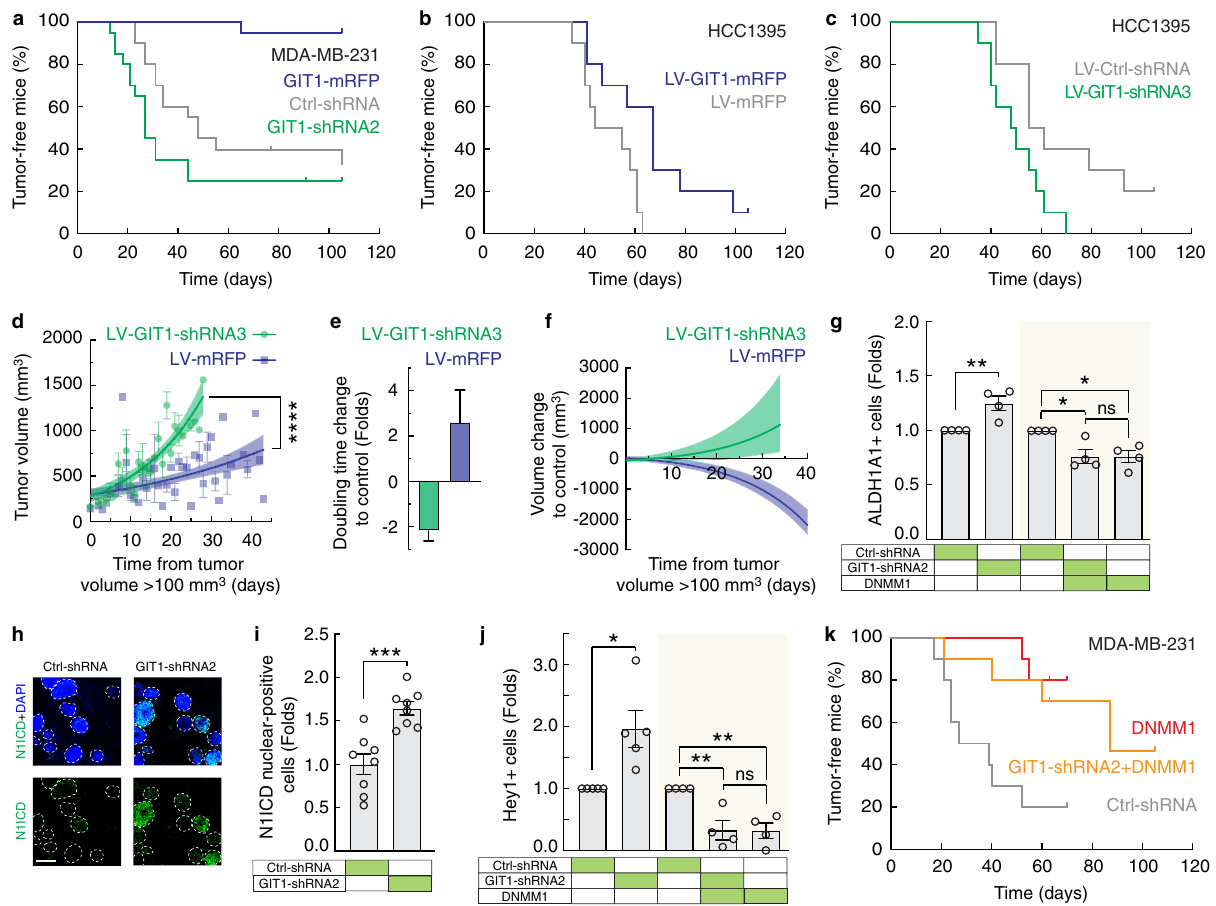
Fig. 5 GIT1 suppresses the in vivo growth of TNBC cells. a – c , k Kaplan – Meier plots showing the percentage of tumour-free mice out of ten mice transplanted with MDA-MB-231 ( a , k ) or HCC1395 cells ( b , c ) stably expressing the indicated plasmids. All injection sites were assessed independently, and a tumour was de fi ned as >100 mm 3 (MDA-MB-231) and >500 mm 3 (HCC1395). Comparisons of Kaplan – Meier curves, MDA-MB-231 implants: Ctrl- shRNA versus GIT1-mRFP, P < 0.0001; Ctrl-shRNA versus GIT1-shRNA2, P = 0.12 ( a ); HCC1395 implants: LV-mRFP versus LV-GIT1-mRFP, P = 0.012 ( b ); LV-Ctrl-shRNA versus LV-GIT1-shRNA3, P = 0.025 ( c ); MDA-MB-231 implants: Ctrl-shRNA versus DNMM1, P = 0.0038; Ctrl-shRNA versus GIT1- shRNA2 + DNMM1, P = 0.030; DNMM1 versus GIT1-shRNA2 + DNMM1, P = 0.58 ( k ); log-rank tests. d Scatter plot of tumour volume over time in the mice transplanted with HCC1395 cells expressing LV-GIT1-shRNA3 and LV-GIT1-mRFP. Time is days from the tumour volume >100 mm 3 . Solid line, exponential regression. Shaded area, 95% con fi dence bands. Comparison of growth rate constants k (Methods) for LV-GIT1-shRNA3 ( n = 290 tumour measurements, k = 0.057) and LV-GIT1-mRFP ( n = 440 tumour measurements, k = 0.023), P < 0.0001; F -test. e , f Tumour doubling time ( e ) and volume change ( f ) for LV-GIT1-shRNA3 versus LV-Ctrl-shRNA and LV-GIT1-mRFP versus LV-mRFP. Solid line, exponential regression. Shaded area, 95% con fi dence interval. g , j Flow cytometric analysis of ALDH1A1 + cells ( g ; n = 4, Ctrl-shRNA versus GIT1-shRNA2, P = 0.0090, t test; Ctrl-shRNA versus GIT1-shRNA2, P = 0.019; Ctrl-shRNA versus DNMM1, P = 0.018; GIT1-shRNA2 + DNMM1 versus DNMM1, P = 1.00; one-way ANOVA, F 2,9 = 7.877, P = 0.011 (shaded area)) and Hey1 + cells ( j , n = 4, Ctrl-shRNA versus GIT1-shRNA2, P = 0.012, t test; Ctrl-shRNA versus GIT1-shRNA2, P = 0.0063; Ctrl- shRNA versus DNMM1, P = 0.0059; GIT1-shRNA2 + DNMM1 versus DNMM1, P = 1.00; one-way ANOVA, F 2,9 = 11.61, P = 0.0032 (shaded area)) in MDA-MB-231 xenograft tumours. h , i Confocal images of the Notch1 ICD (N1ICD)-immunolabelled MDA-MB-231 xenograft tumours ( h ) and quantitative analysis ( i ; n = 8 tumours, P = 0.0004, t test). Nuclei were detected using DAPI. Scale bar, 5 μ m. All data are shown as the mean ± s.e.m. n denotes the number of biologically independent replicates, unless stated otherwise. * P < 0.05, ** P < 0.01, *** P < 0.001, **** P < 0.0001, ns, not signi fi cant by two-sided unpaired t test, F -test, or one-way ANOVA with Tukey ’ s post hoc comparison. Source data are provided as a Source Data fi